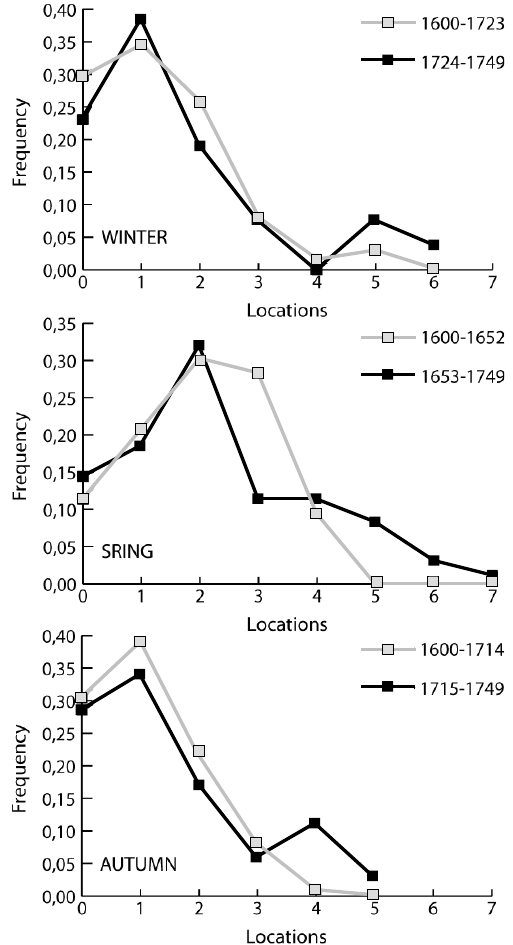
Fig. 6. Frequency of different drought extensions from 0 (no drought detected during the season) to 7 (drought detected in all the studied locations) during periods 1 and 2 in winter, spring and